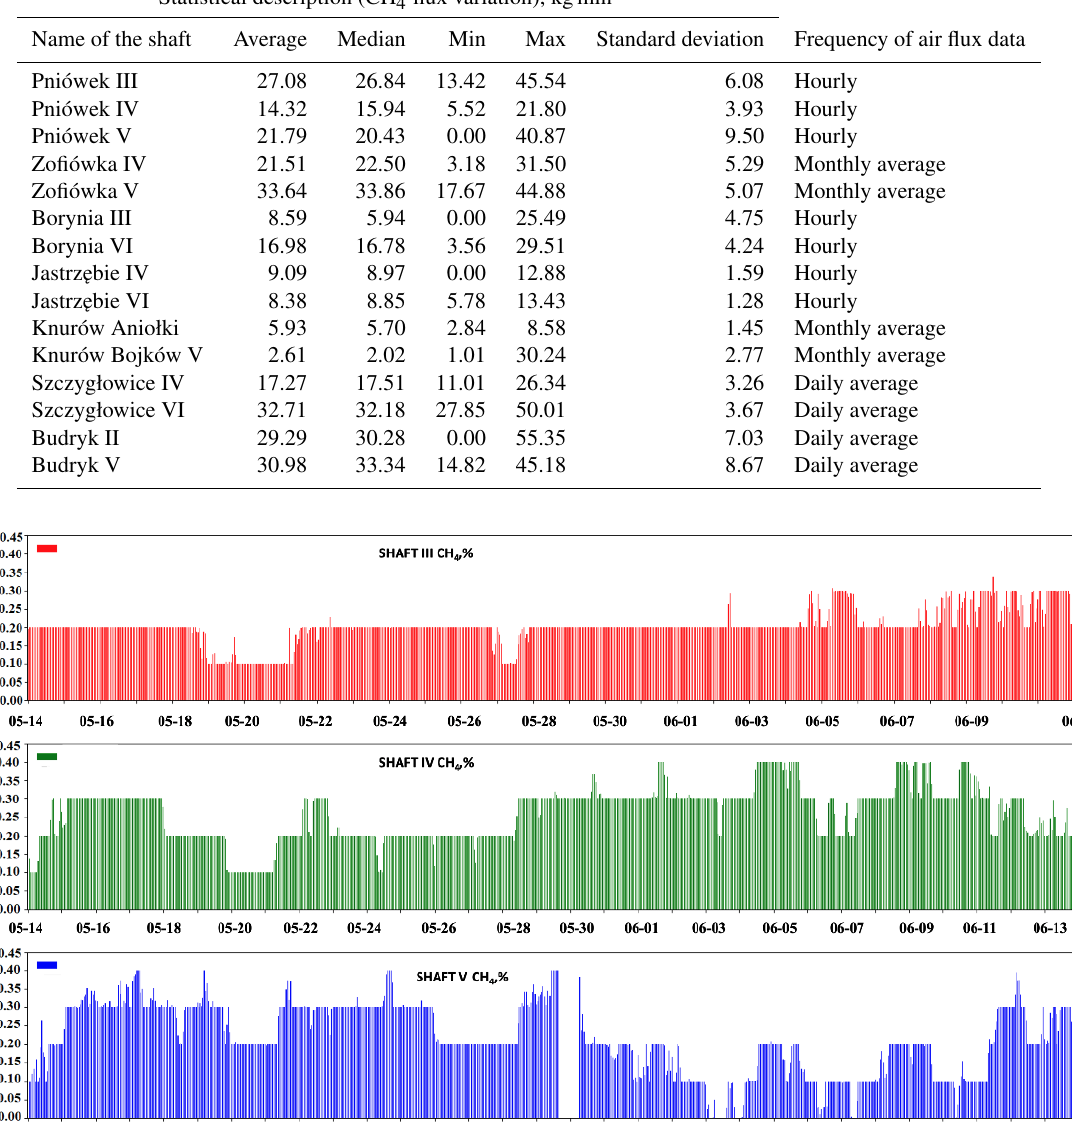
Table 3. The statistical description of methane fluxes calculated for ventilation shafts analysed in the study (period from 14 May to 13 June 2018). Frequency of the flux data varies according to the frequency of the base data provided by the administration of the respective mines.